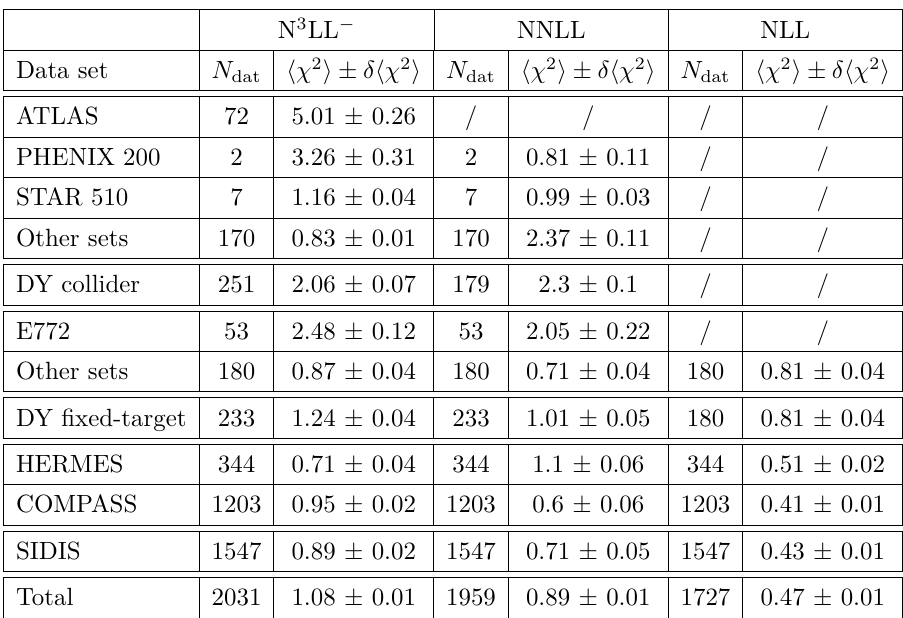
Table 6 . Comparison of χ 2 values normalised to the number of data points N dat for fits at different perturbative accuracies. The of all